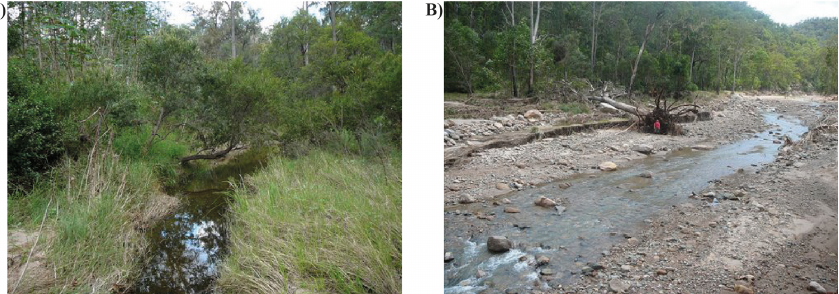
Figure 4. (a) Pre-flood (2010) and (b) post-flood (2011) photography of Paradise Creek (Fig. 2) in the upper Lockyer Valley, showing catastrophic channel stripping and